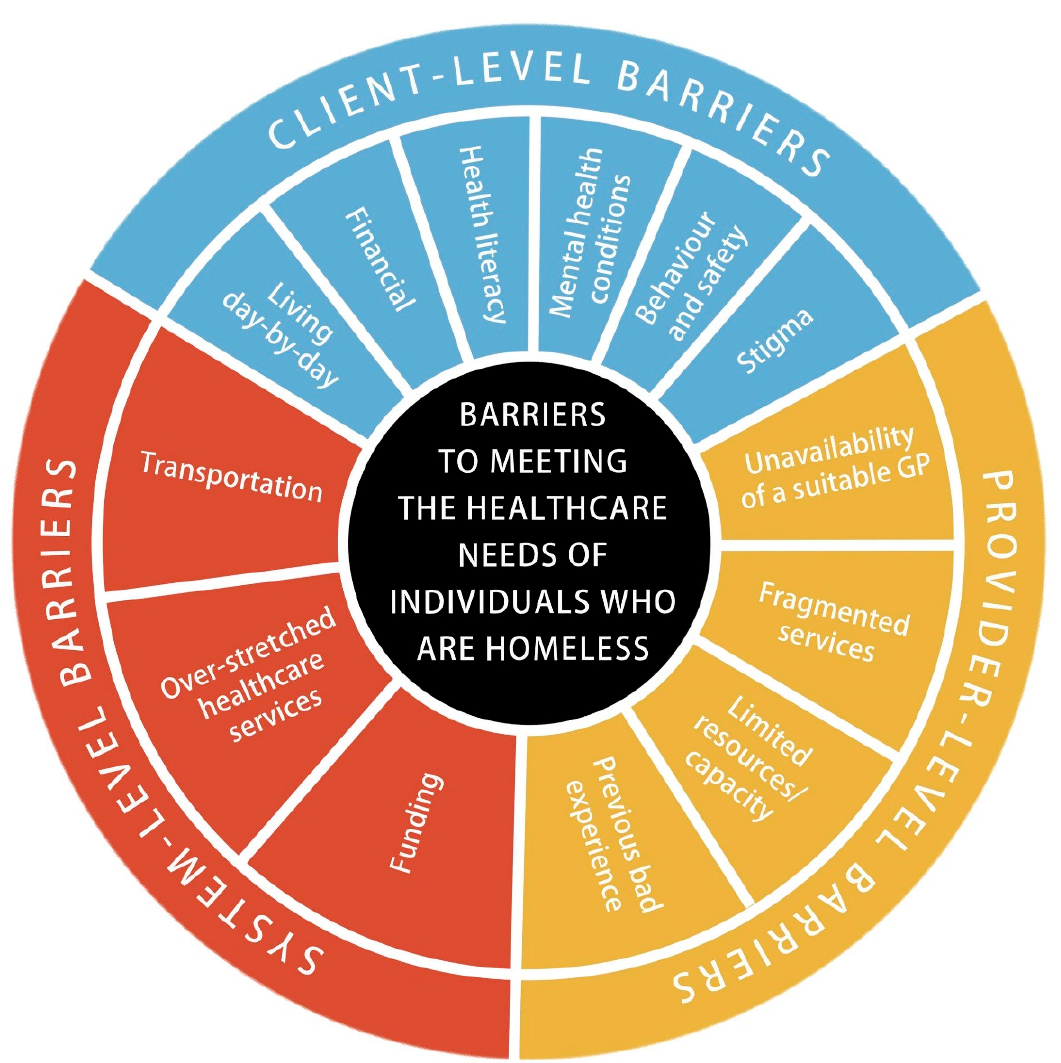
Figure 2. Barriers to meeting the healthcare needs of individuals experiencing homelessness.